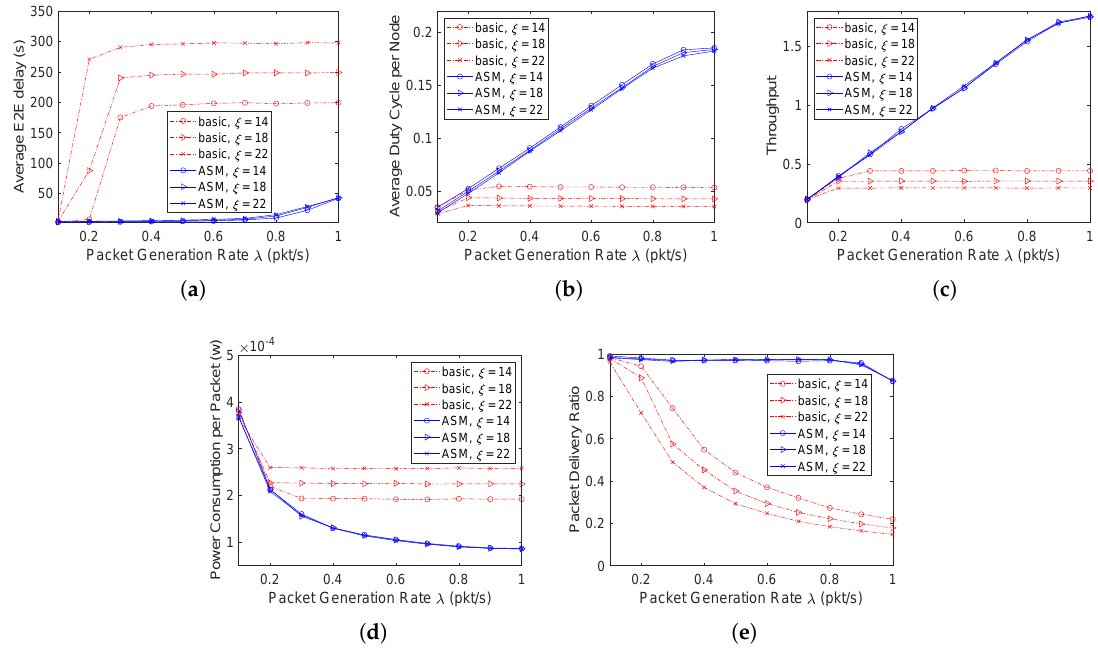
Figure 8. Performance evaluation in the double-chain network scenario. ( a ) Average E2E delay. ( b ) Average duty cycle. ( c ) Throughput. ( d ) Average power consumption. ( e ) Packet delivery